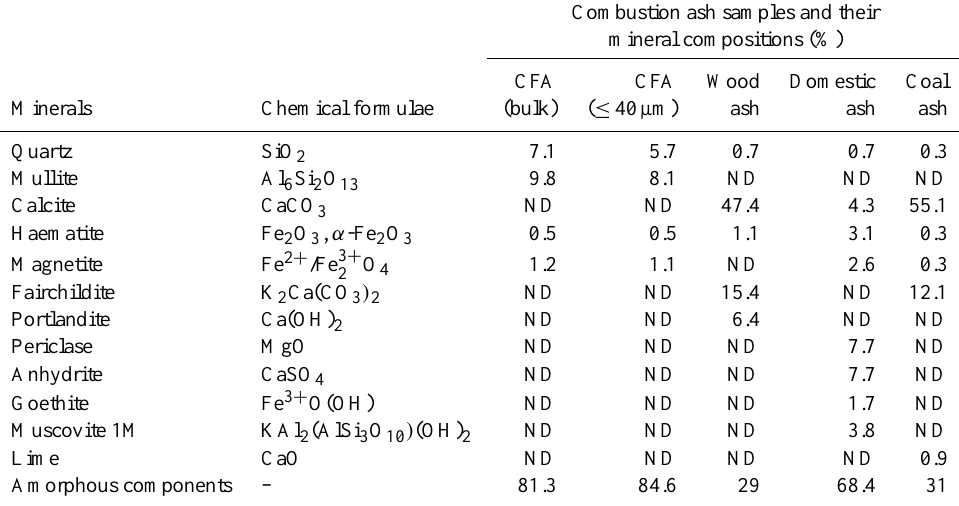
Lime CaO Amorphous